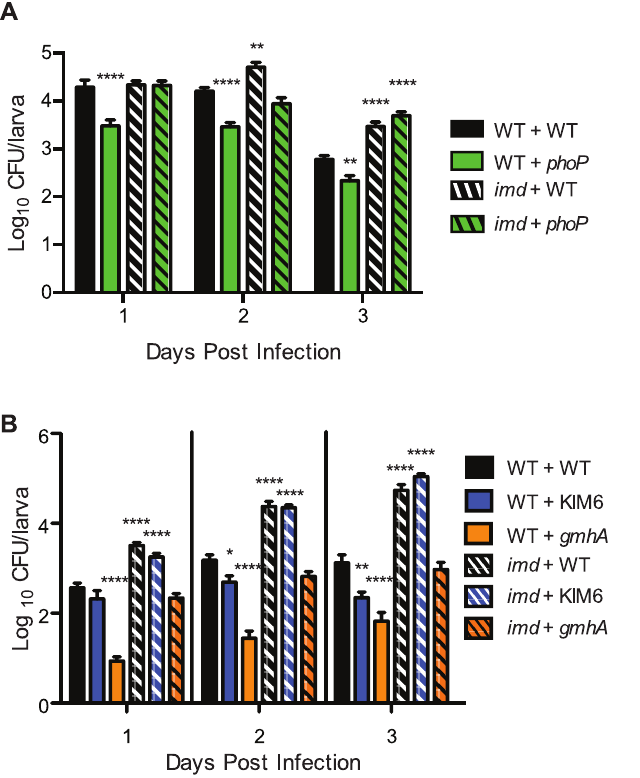
Fig 5. Host AMP production controls Y . pestis colonization. Wild type (WT) or imd mutant Drosophila larvae were infected with WT or mutant Y . pestis strains, and bacterial loads per larvae were monitored over three days. (A) WT (solid bars) and imd mutant (striped bars) fly strains were infected with WT KIM6+ (black) or the phoP mutant (green). Infections were performed at least in triplicate (n (cid:1) 15 for each bar) and data were pooled. (B) WT (solid bars) and imd mutant (striped bars) fly strains were infected with WT KIM6+ (black), KIM6 (blue), or the gmhA mutant (orange). Bacterial loads in WT flies were determined by plating homogenates on YSA, whereas imd flies were analyzed by qPCR. Infections were performed at least in triplicate (n (cid:1) 25 for each bar) and data were pooled. For both panels, means with standard error are